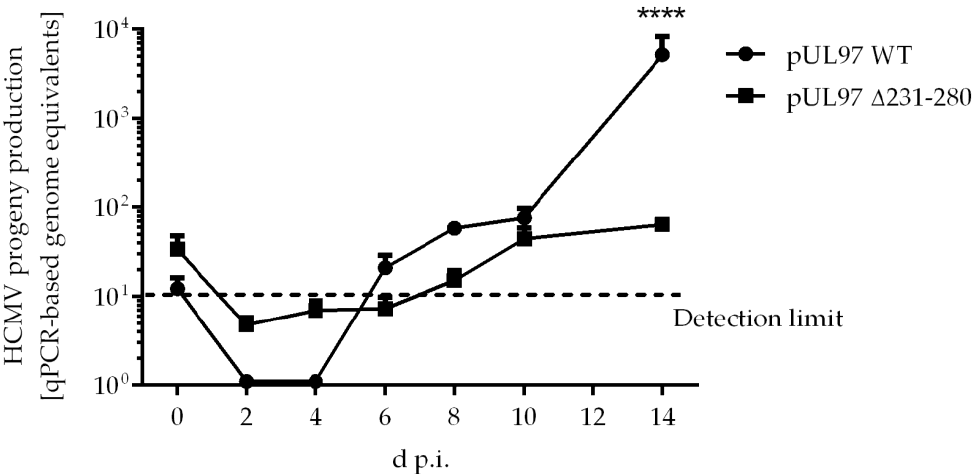
Figure 5. Viral replication kinetics of pUL97 WT and pUL97 ∆ 231-280 determined by HCMV-specific qPCR. In total, 225,000 HFFs in 12-well plates were infected with parental HCMV strain AD169- GFP WT or AD169-GFP pUL97 ∆ 231-280 at an MOI of 0.001. Viral supernatants were harvested at indicated time points and viral genome equivalents were determined by qPCR. Each value represents the mean ± SD of two independent biological replicates, each measured twice. Statistical analysis was performed using an ordinary two-way ANOVA and post-hoc Sidak correction; ****, p < 0.0001.